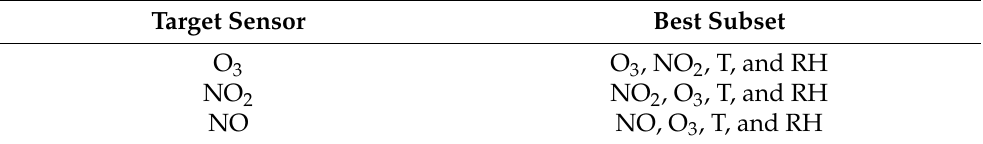
Table 4. Machine learning calibration best subset of sensors found via forward stepwise feature selection.